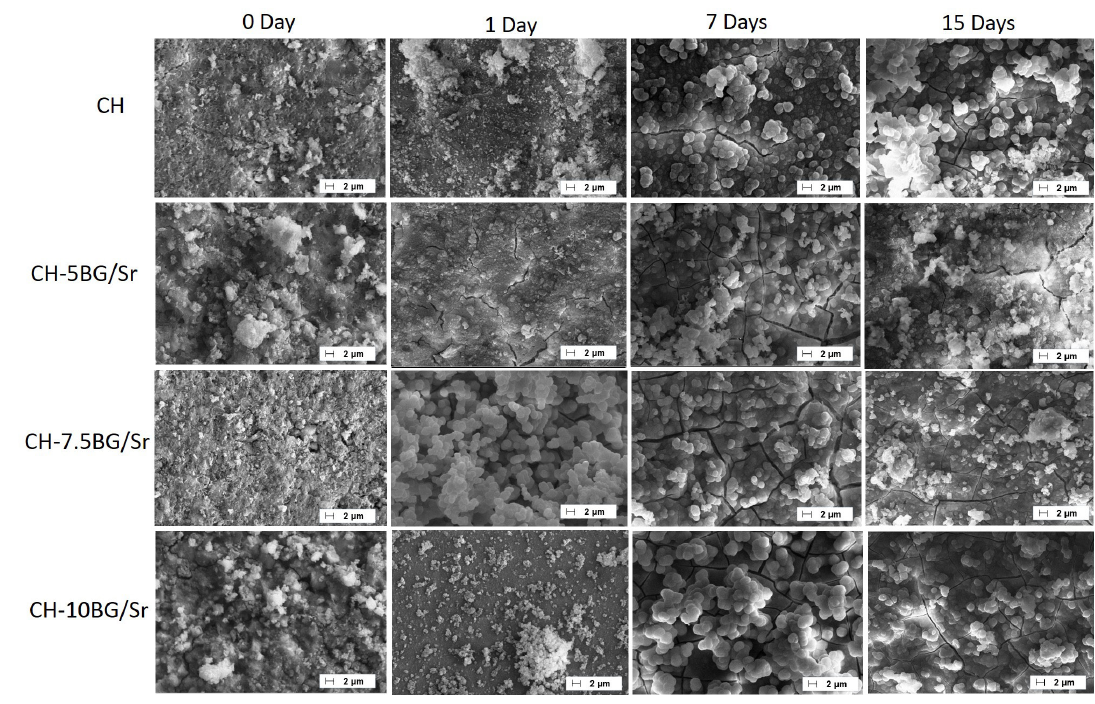
Figure 4. SEM micrographs for blends based on homogeneous calcium aluminate cement (CH) containing different contents of bioactive glass (BG) and 1 wt% strontium (Sr), without or with SBF treatment for 1, 7 and 15 days. The fractures in the newly developed layers were caused by the drying of the